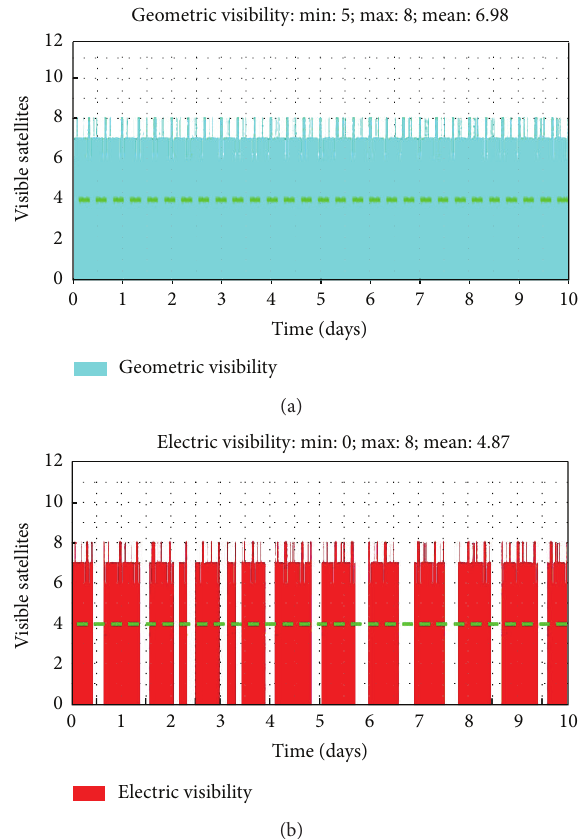
Figure 17: Number of visible satellites − 24/24GPS constellation and 1RF interfering satellite.